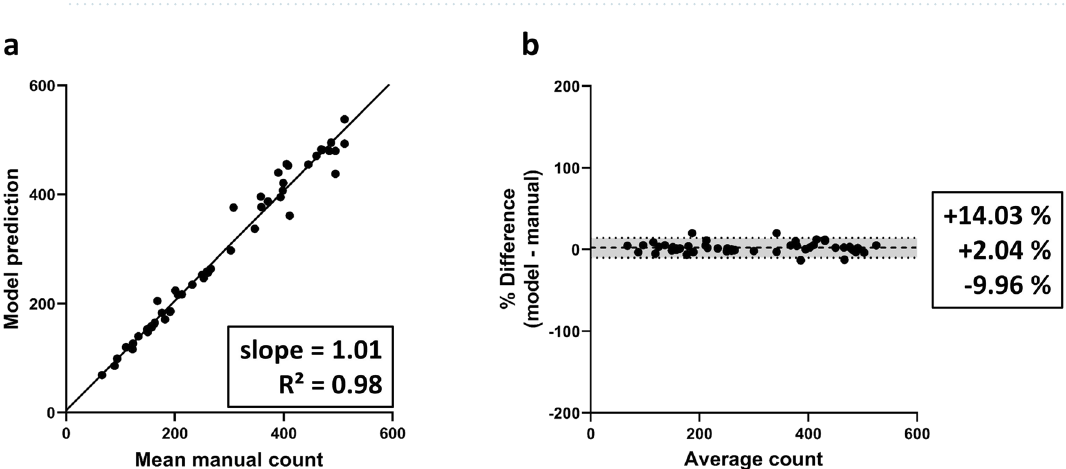
Figure 2. Linear regression and bias analysis of automated counts on retinal frames. ( a ) Linear regression analysis for the average of the manual counts versus model output indicates that the automated counts show a very high linear relationship with manual counts. Best-fit linear regression correlation coefficient ( R are indicated. ( b ) Bland–Altman analysis of the automated counts compared to the operator average, showing mean bias ± 95% limits of